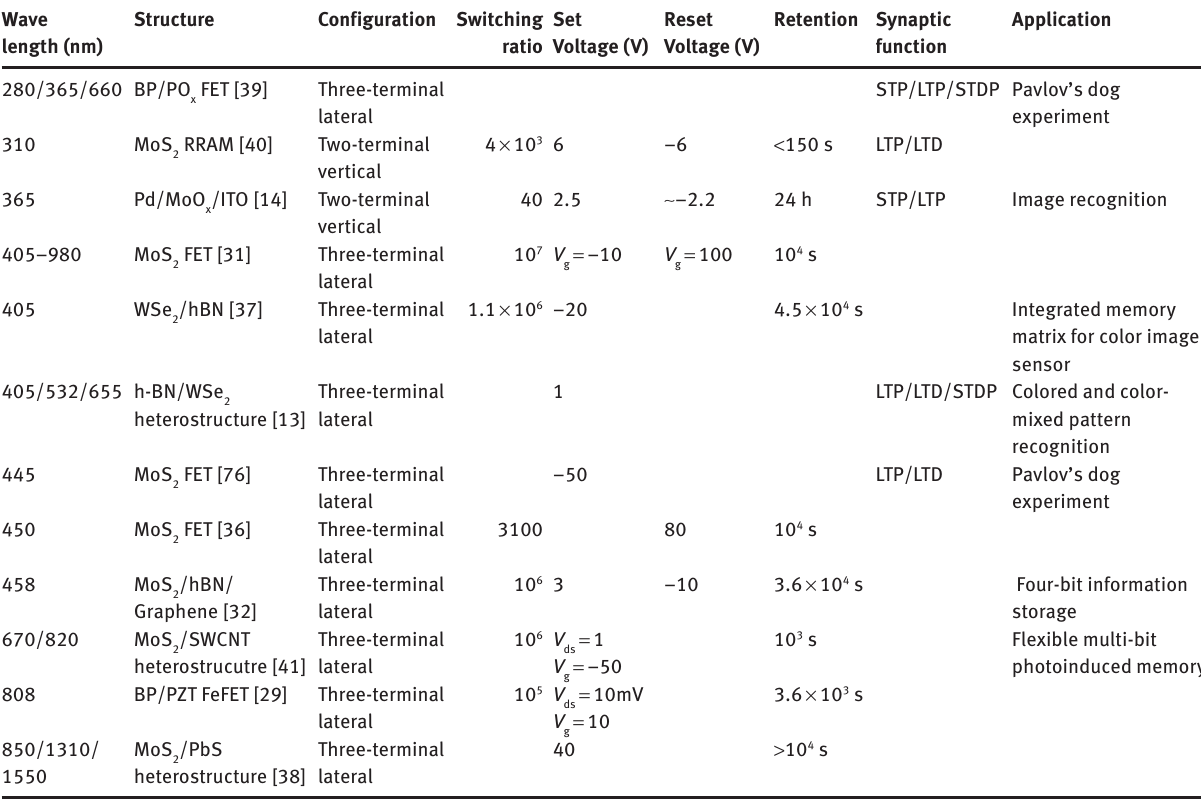
Table 1: Electrical performance of 2DMs photonic memristors reported in the literature. Wave length (nm)